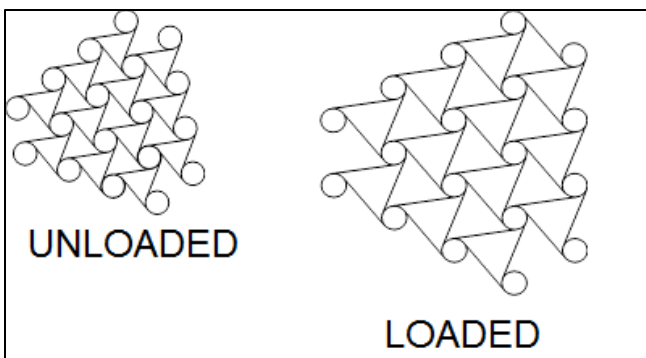
Figure 4. Chiral auxetic behaviour